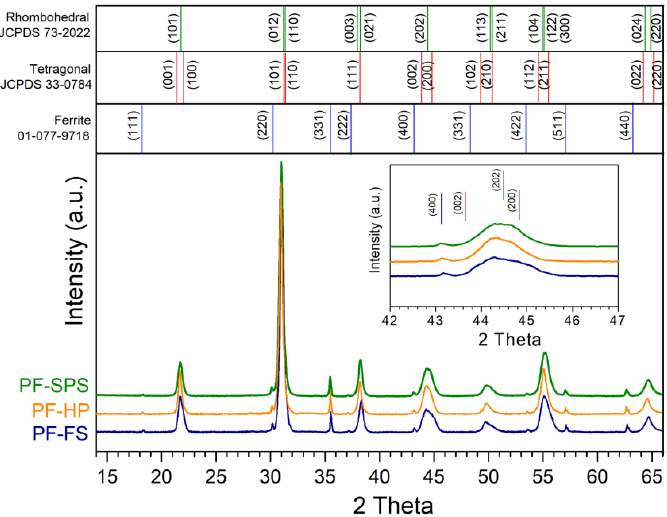
Figure 2. X-ray diffraction patterns for the PF multiferroic composites.